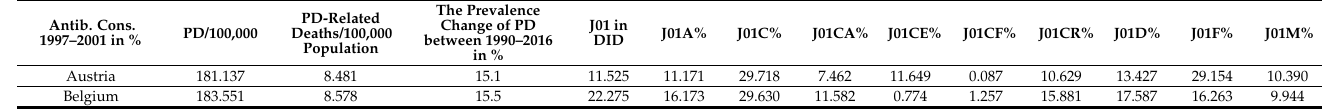
Table 1. Average antibiotic consumption for 1997–2001 expressed as a relative share in % of the total systemic antibiotic consumption in the community estimated in Defined Daily Dose/1000 Inhabitants/Day (DID) compared to the prevalence of PD estimated for 2016, the change of prevalence between 1990–2016 in percentage (%), and the PD-related deaths/100,000 population. Positive, significant correlation or significantly elevated risk was estimated when the p -value showed ≤ 0.05 ( p = ≤ 0.05) (marked with yellow filling color) and the negative correlation or lowered risk was marked with green filling color. Positive/negative, non-significant correlations or elevated/lowered risks were considered when the p -value fell between 0.051 and 0.09 ( p = 0.051 ≤ 0.09) and marked with an orange filling